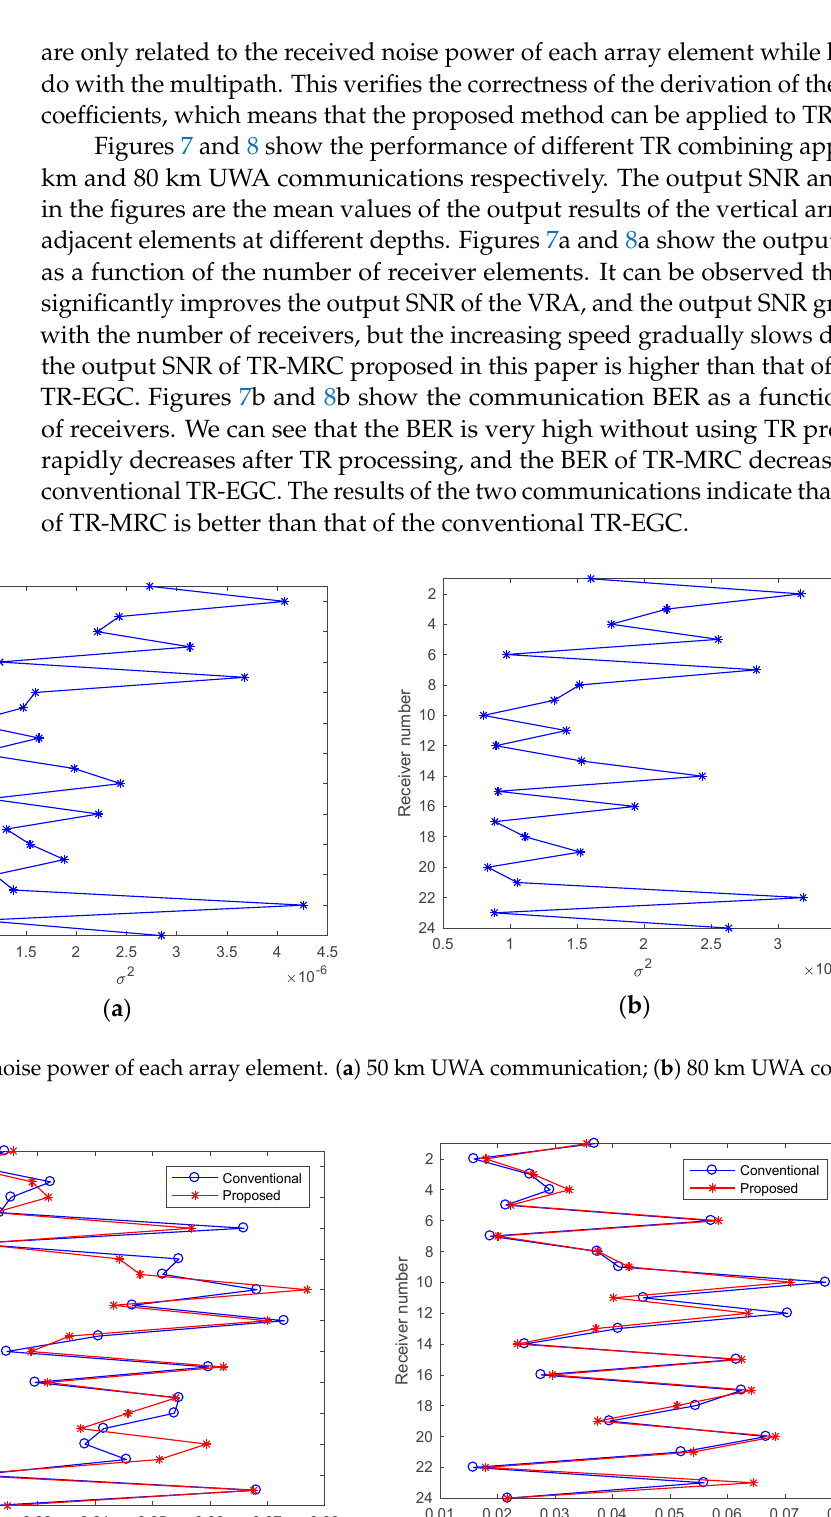
( b ) Figure 7. Performance of 50 km UWA communication as a function of the number of receivers. ( a ) Output SNR; ( b ) BER. Note: EGC means using EGC without TR processing.